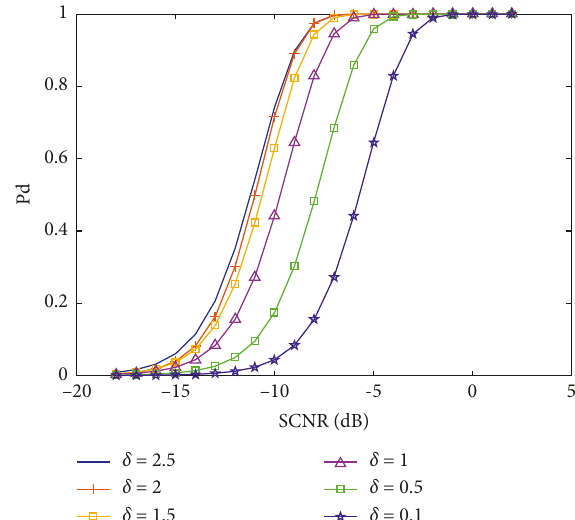
Figure 6: Detection probability vs. SCNR. Algorithm 3: continuous phase sequence.